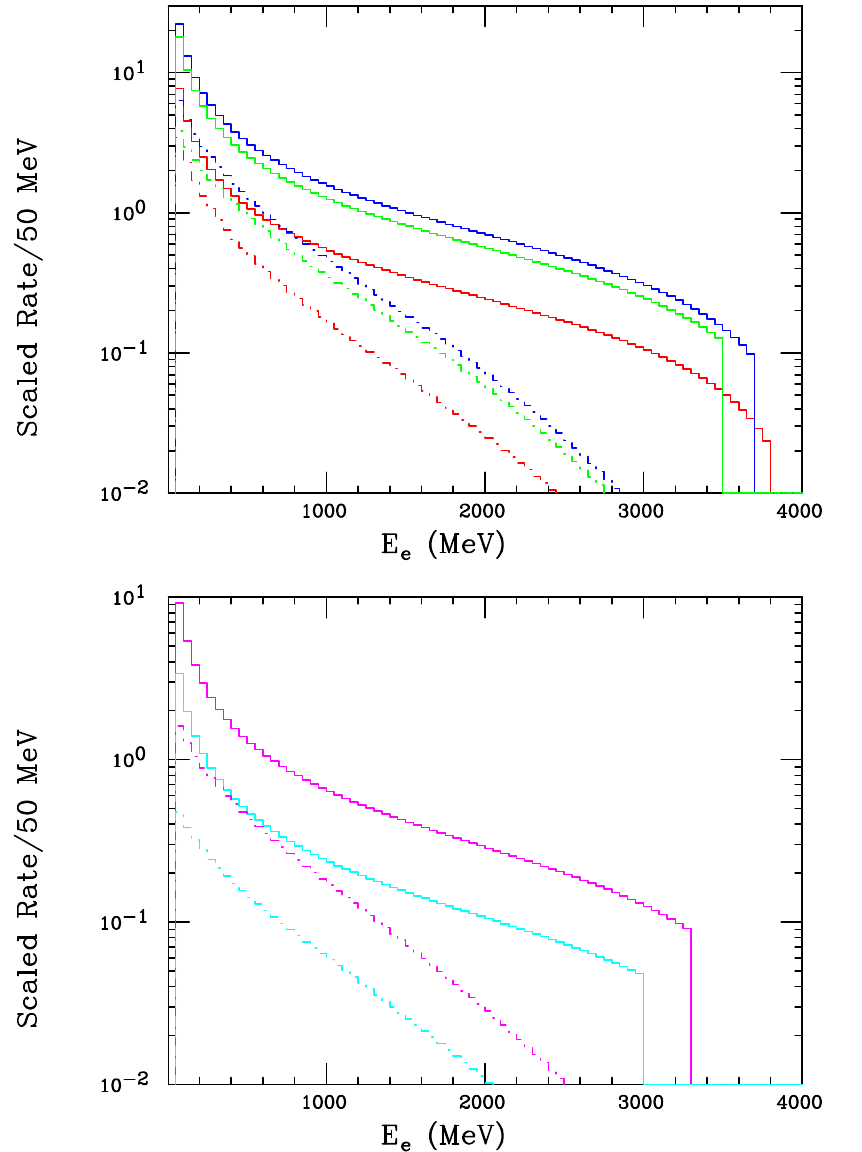
Figure 6 . Comparison of the scaled electron recoil energy distribution for the familiar KM (cid:15) 2 vector coupling scenario (solid) and the dark magnetic dipole model presently under consideration (dash dot) assuming that m V = 100 (red), 300(blue) or 500(green) MeV in the top panel and m V = 700 (magenta) or 1000(cyan) MeV in the bottom panel, respectively. The normalization of all curves have been floated to fit these results onto these two panel to show their details and so only overall shape comparisons are relevant